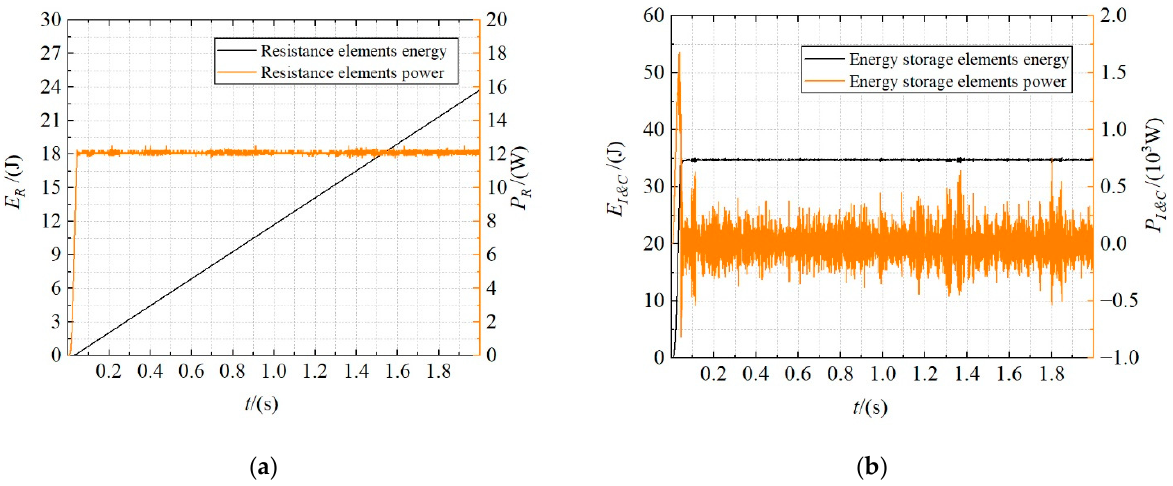
Figure 23. ( a ) The energy and power curve of the resistance elements; ( b ) The energy and power